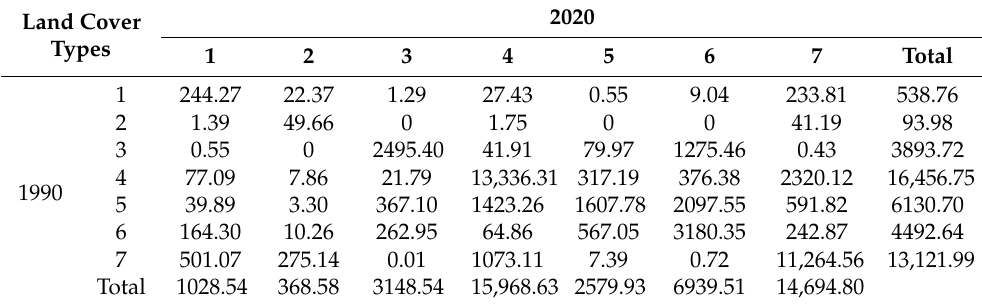
Table 2. Land cover type transfer matrix for GRB from 1990 to 2020 (unit: km 2 ). Land Cover